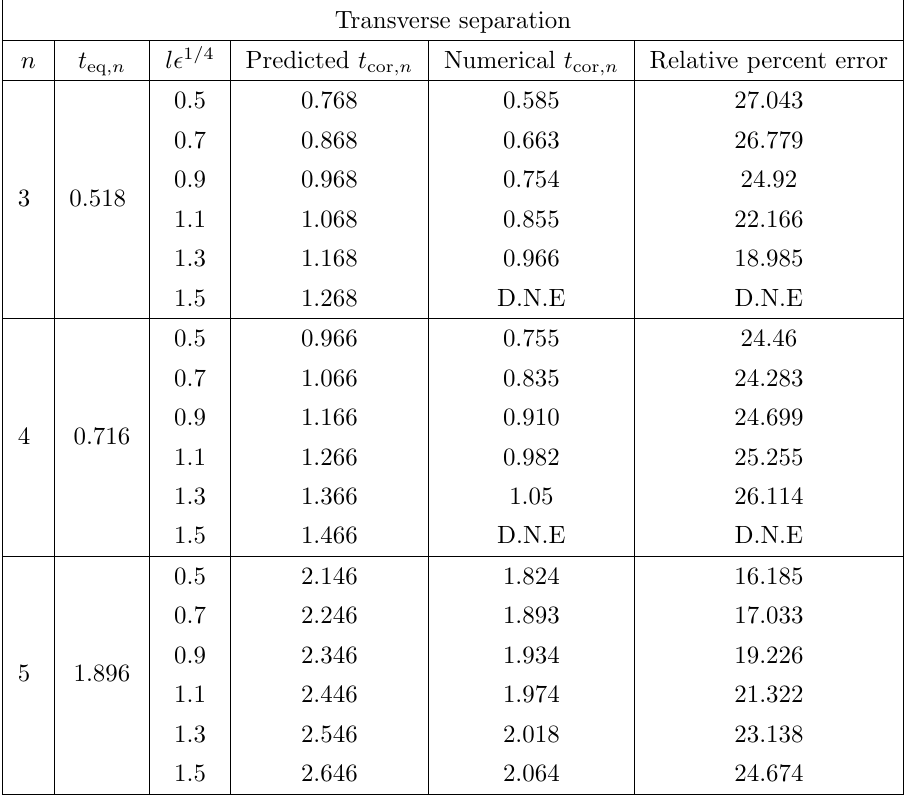
Table 7 . Example equilibrium times of the 1-point functions, t eq ;n , and 2-point functions, t cor ;n , in a thermalizing (cid:13)uid (dual to the evolution towards a magnetic black brane geometry) with B = 1 and (cid:26) = 0. Entries of D.N.E stand for Does Not Exist, this can be seen in the red curves displayed in the top two graphics of (cid:12)gure 13. The correlation functions of this length scale are lifted above the